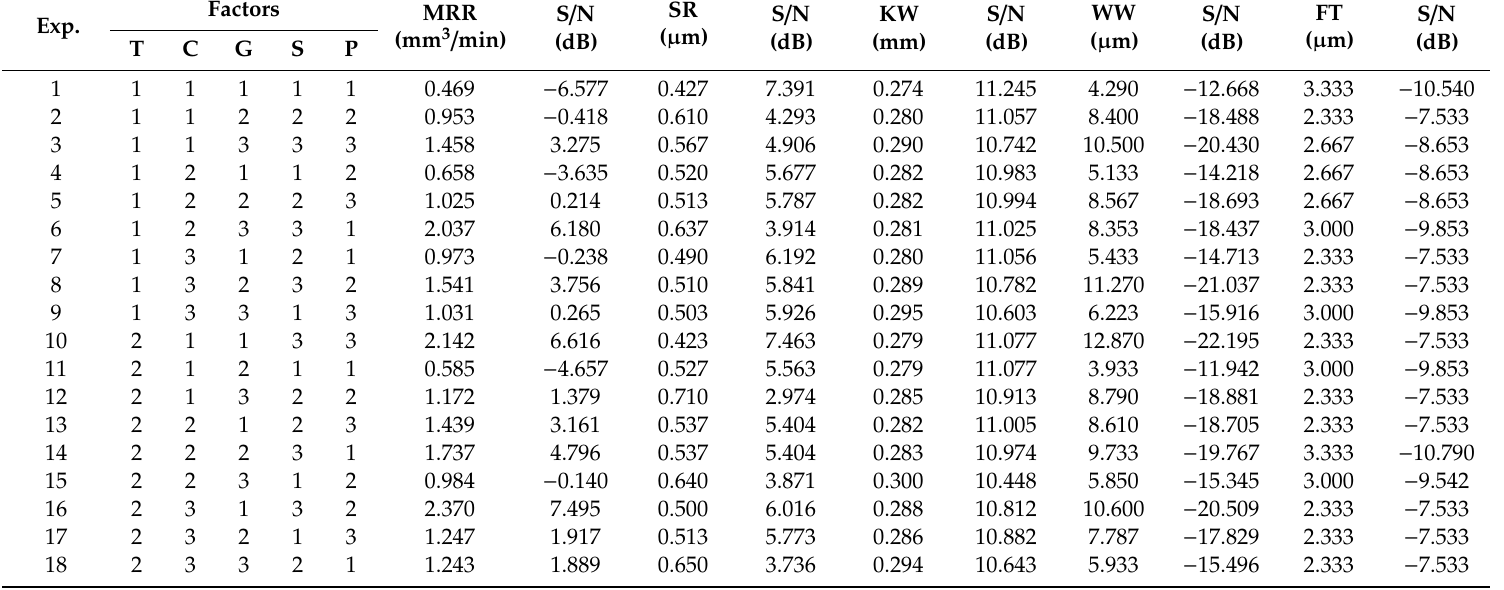
Table 3. Experimental conditions, data, and the associated S / N ratios for multiple quality